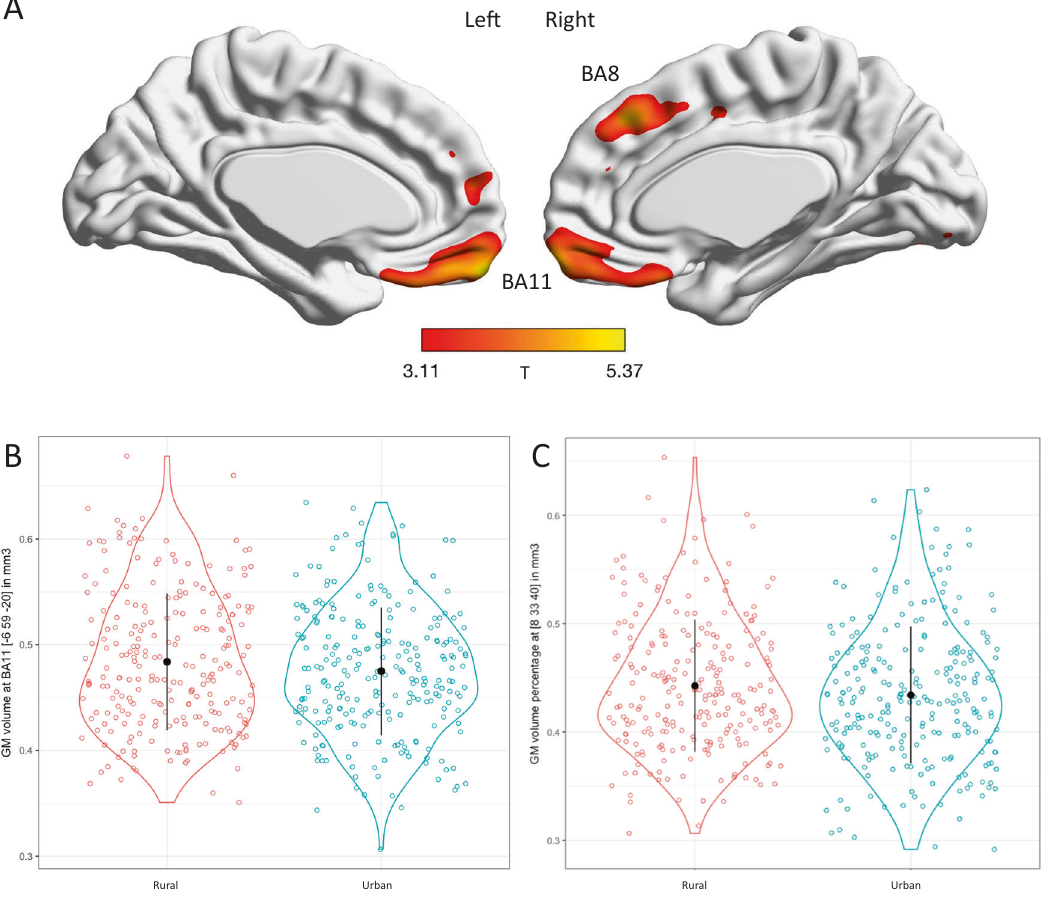
Fig. 2 Childhood urbanicity effect on gray matter volume suggested by MRI (N = 490). A Brain map of the rural vs urban gray matter volume effects as suggested by MRI (shown at p < 0.001 uncorrected but peaks survived p < 0.05 whole-brain voxel-wise FWE corrected for multiple comparisons). B Plot of rural vs urban effects at Brodmann area 11 in medial prefrontal cortex (peak x = − 6, y = 59, z = − 20, t = 4.81, p < 0.05, whole brain voxel-wise FWE-corrected). C Plot of rural vs urban effects at Brodmann area 8 in mPFC (peak x = 8, y = 33, z = 40, t = 4.73, p < 0.05, whole-brain voxel-wise